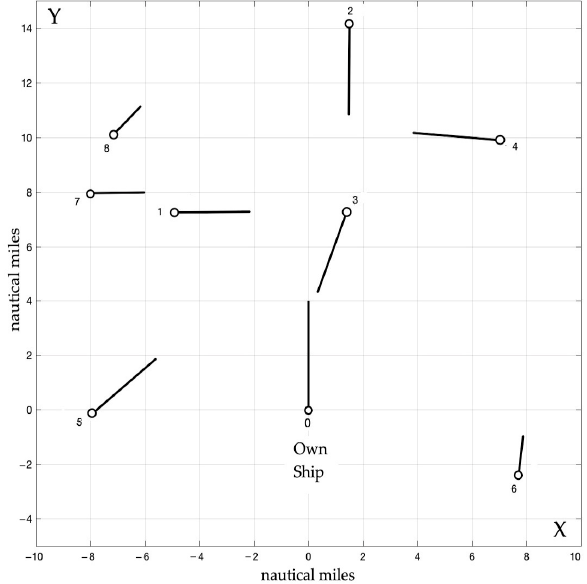
Figure 11. Illustrating the navigation situation in the form of twelve-minute speed vectors of one’s own ship and eight encountered ships.